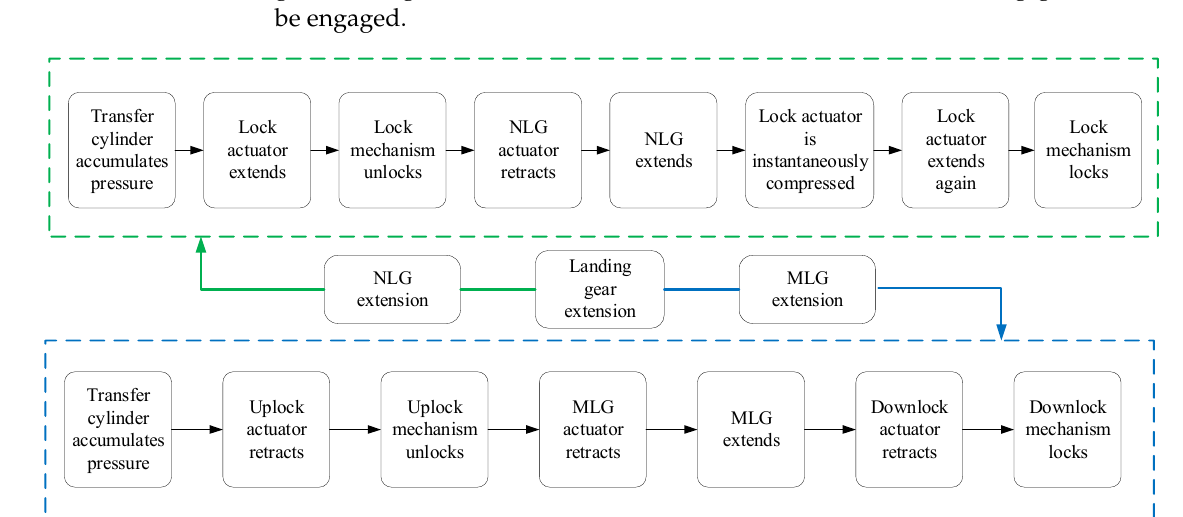
Figure 2. Logical sequence of extending (NLG: Nose Landing Gear; MLG: Main Landing Gear).